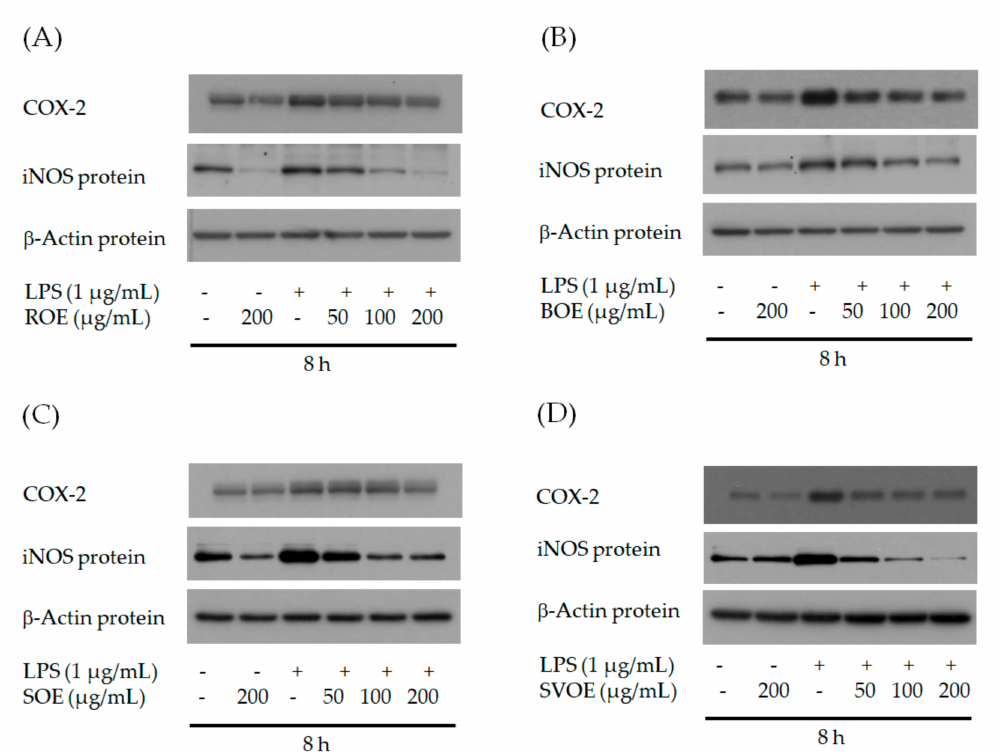
Figure 3. Effect of cooking method and okra extract on cycloxygenase-2 (COX-2) and inducible nitric oxide synthase (iNOS) protein expression in LPS-induced RAW264.7 cells. Cells were treated with ROE ( A ), BOE ( B ), SOE ( C ), and SVOE ( D ) (50, 100, 200 µ g/mL), with or without LPS (1 µ g/mL) for 24 h. The COX-2 and iNOS expression were normalized to the β -actin signal (the relative band intensities are indicated above each band). iNOS: inducible nitric oxide synthase, LPS: lipopolysaccharide, ROE: raw okra ethanol extract, BOE: blanched okra ethanol extract, SOE: steamed okra ethanol extract, and SVOE: sous-vide cooked okra ethanol